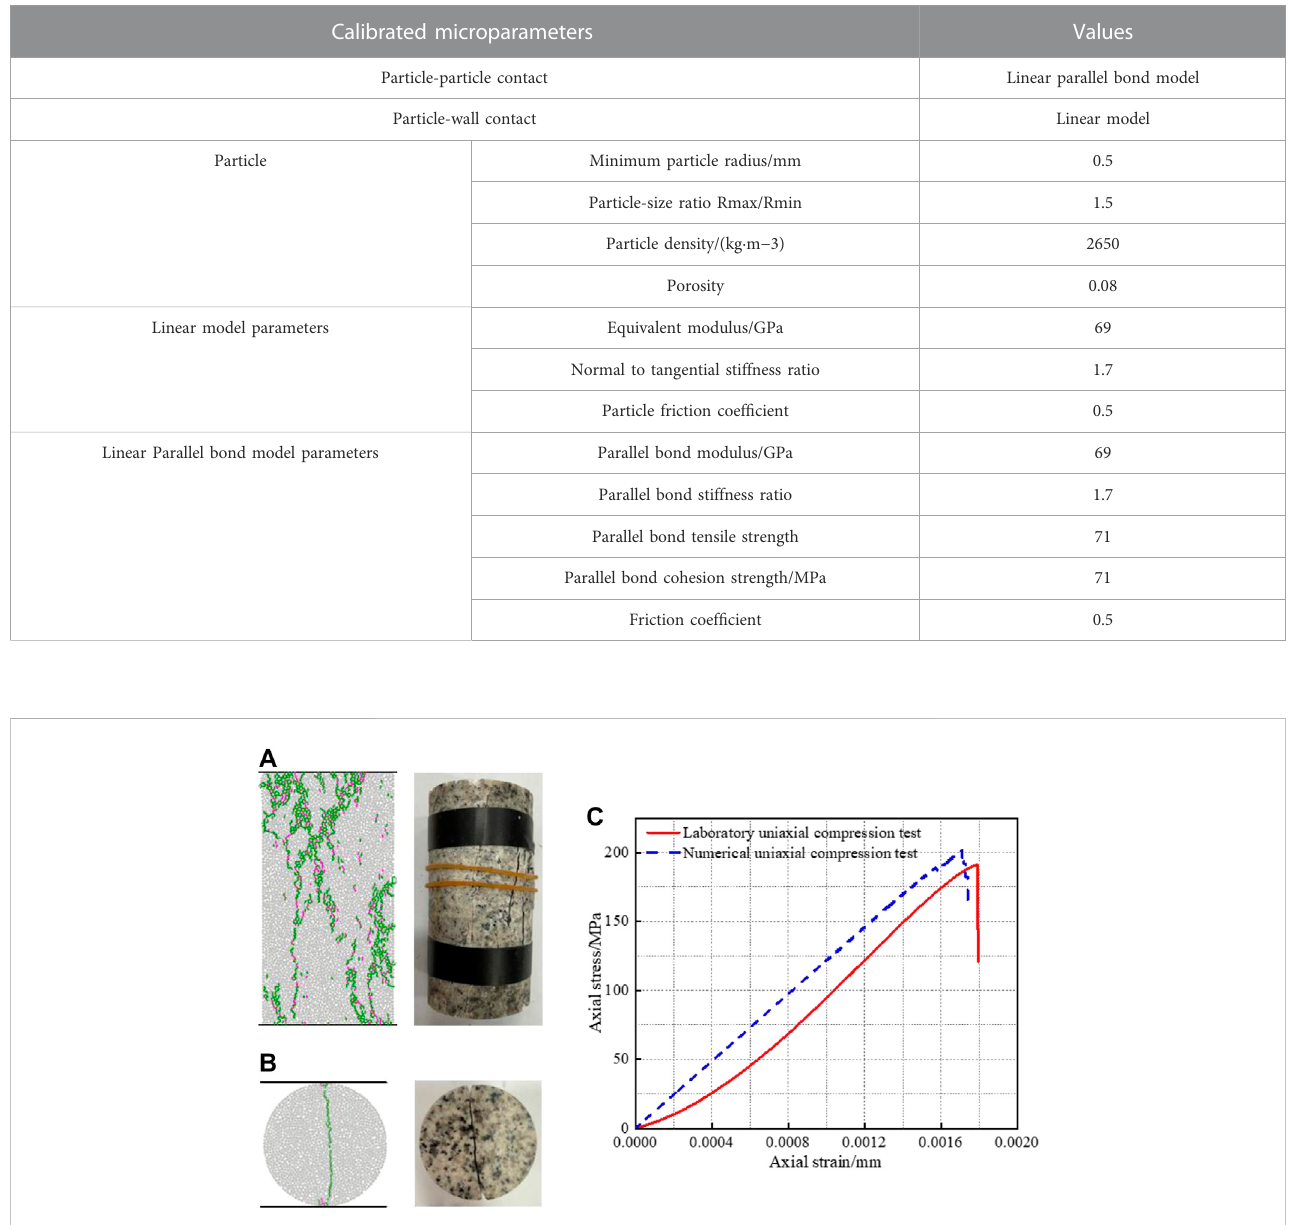
TABLE 1 Mesoscopic parameters of rocks.